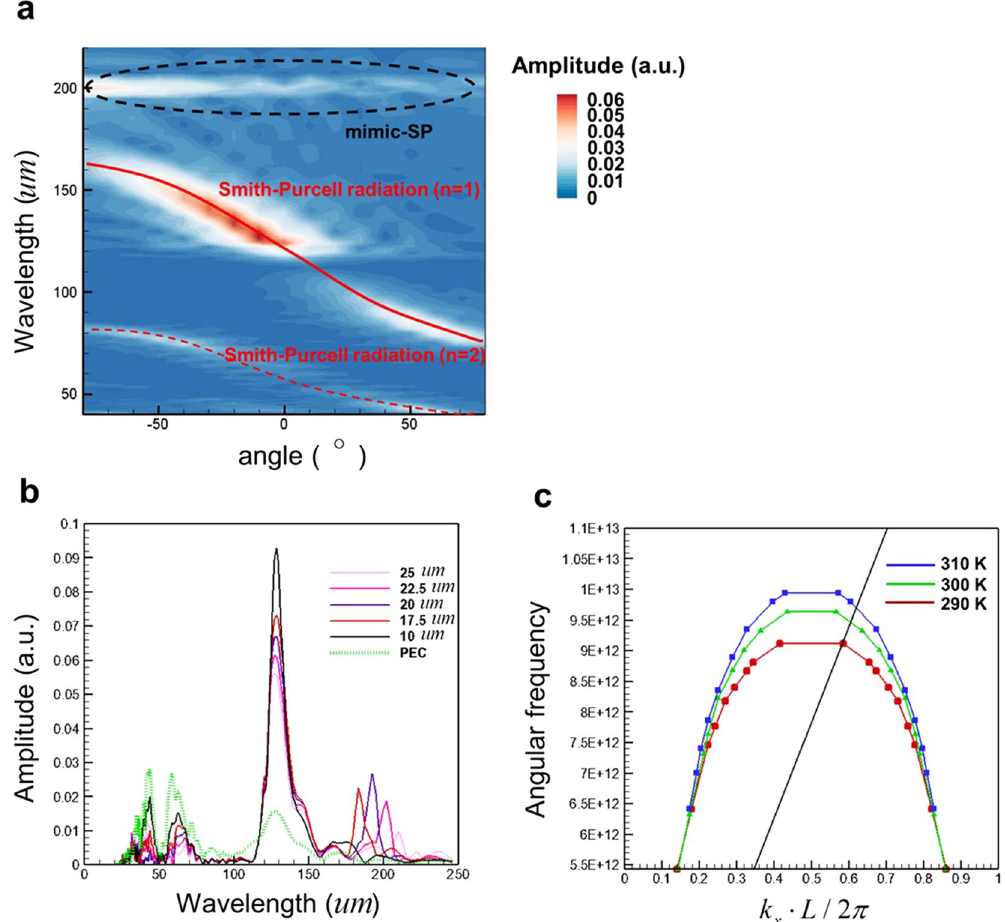
Figure 4. Simulated results for an electron bunch passing over an InSb grating. ( a ) Simulated contours of Fourier spectra of Hz fields versus emission wavelength and angle at the observation points ( h = 22.5 u m). Red solid (dashed) line also denotes the wavelength-angle relation of traditional SPR for n = 1 ( n = 2). ( b ) Simulated Fourier spectra of Hz field as a function of wavelength at θ = − 10° ( R = 700 u m) for an InSb grating with various values of h and a PEC grating with h = 22.5 u m. ( c ) Dispersive curves of mimic SP with various temperatures (red, green and blue lines) and electron bunch with E = 40 keV (black line). h = 22.5 u